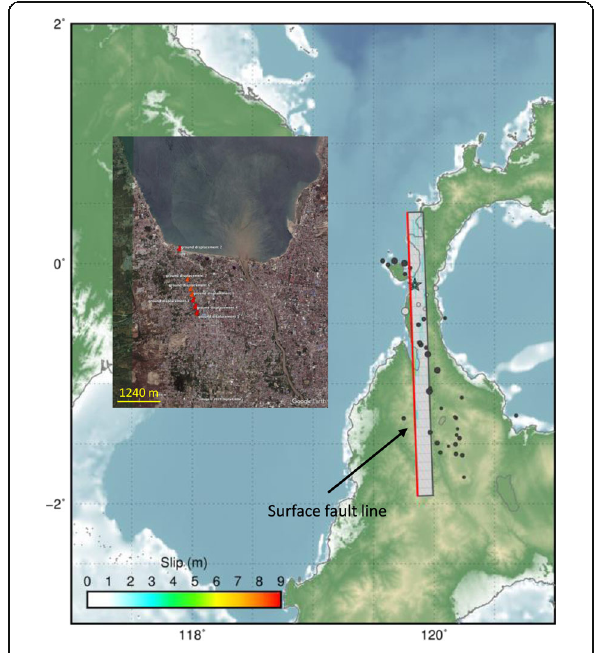
Fig. 3 Fault line at surface estimated by USGS